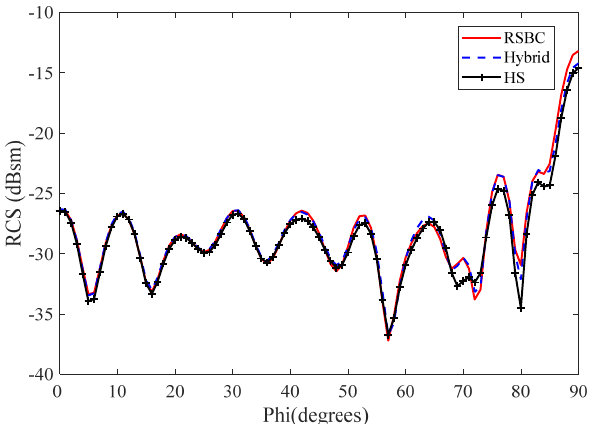
Figure 12. The computed VV-polarized bistatic RCSs of the wing-like object at 4.5 GHz using different approaches.